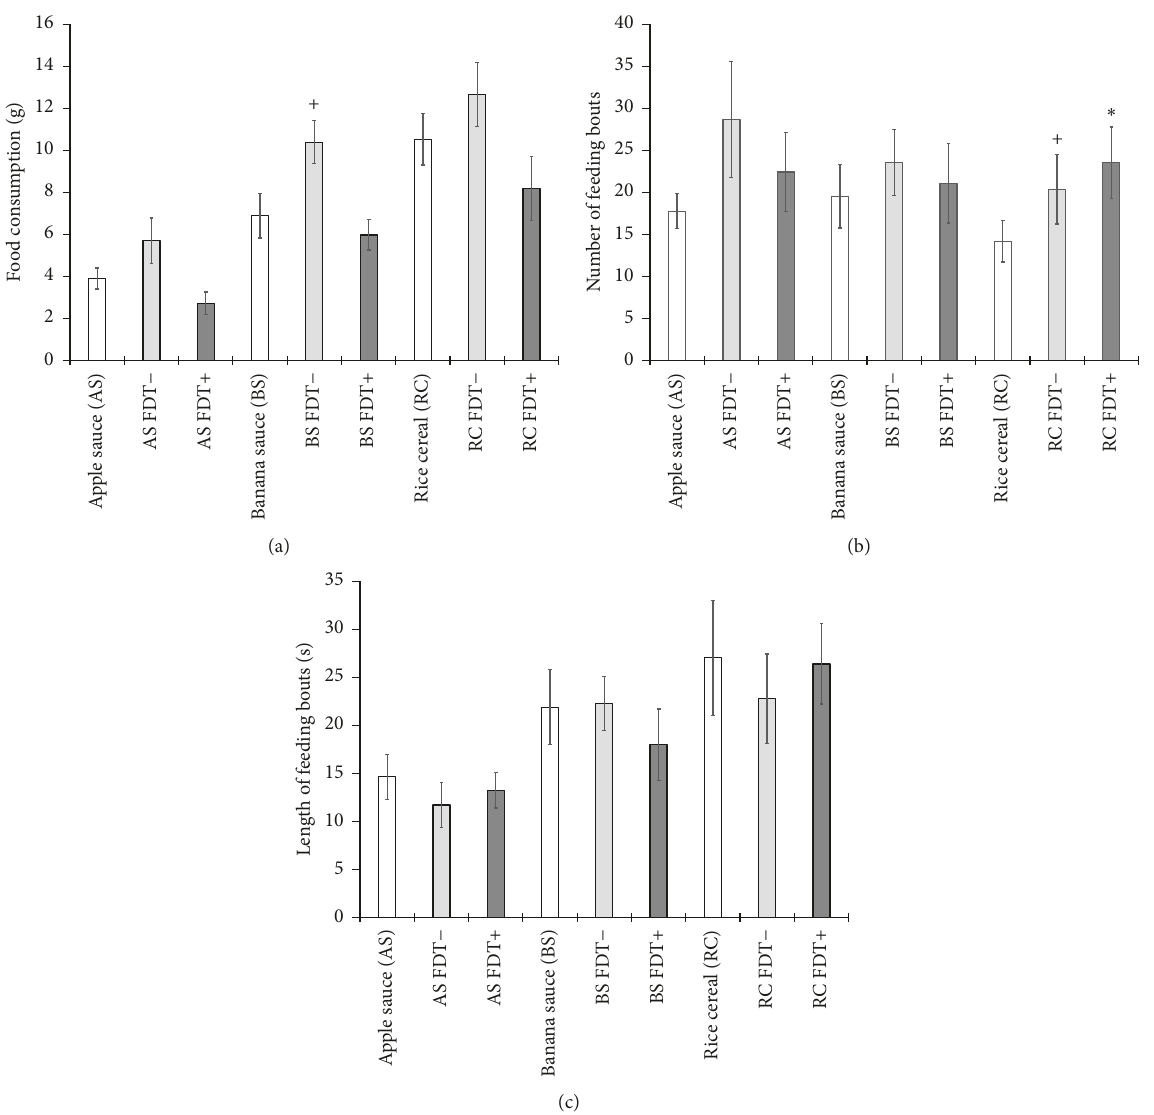
Figure 7: Consumption patterns of applesauce (AS), banana sauce (BS), or rice cereal (RC) alone (open bars), with the FDT − placebo (light bars) and the FDT+ (dark bars) with bars representing means with SEM error bars. Star ( 𝑝 < .01 ) and plus ( 𝑝 < .05 ) symbols represent significant increases compared with control foodstuffs (open bars). (a) Total grams consumed during the 1-h consumption test. (b) Average number of feeding bouts defined by a pause ≥ 1 second. (c) Average length of each feeding bout.